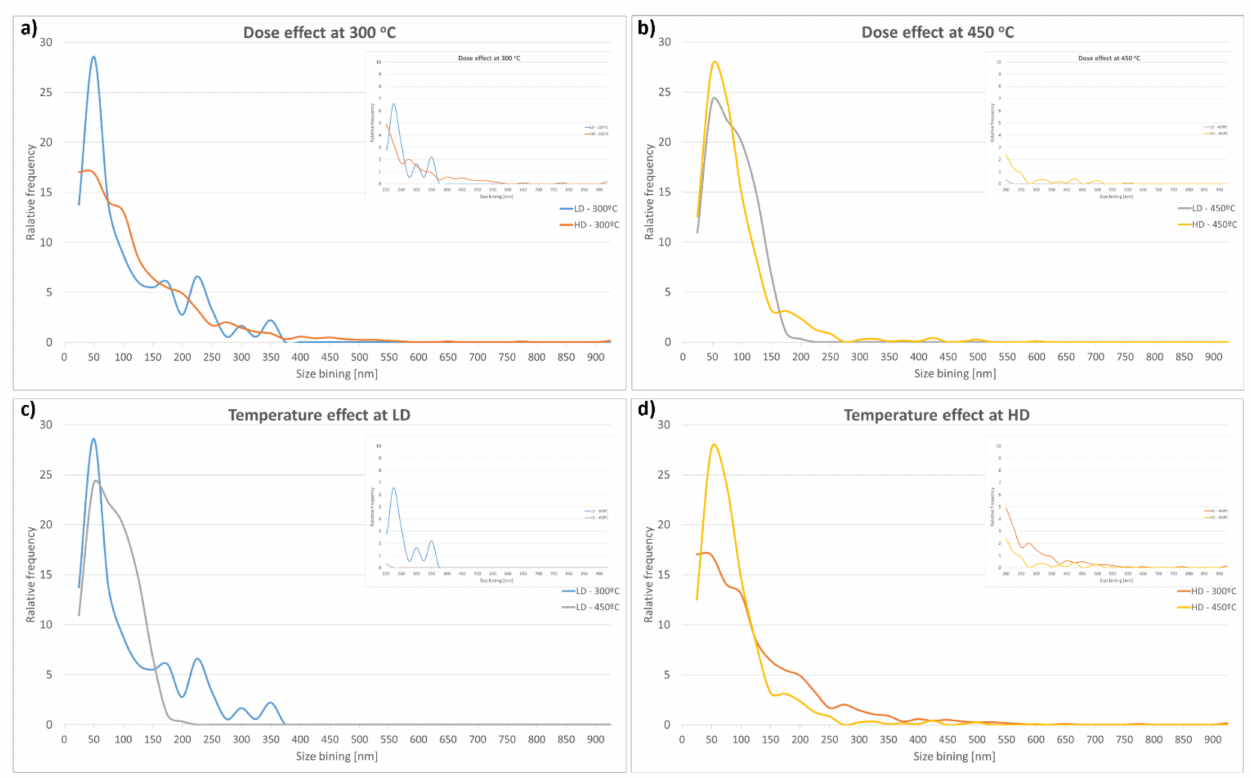
Figure 28. Effect of increasing the irradiation dose at constant temperatures of ( a ) 300 ◦ C; and ( b ) 450 ◦ C, and of increasing the irradiation temperature for the same effective doses—( c ) low dose; and ( d ) high